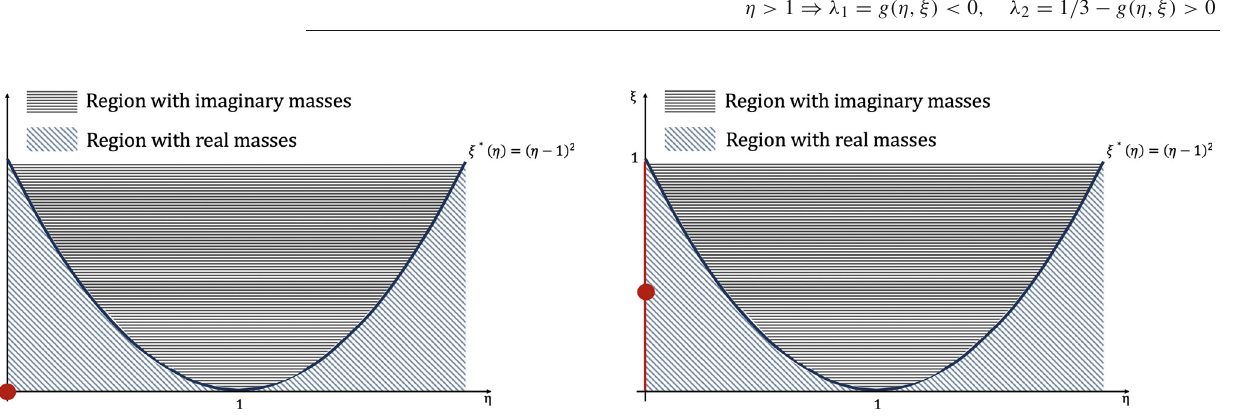
Fig. 2 In the space defined by parameters (η,ξ) some classes of mod- els (1) could be represented with a representative point in the η ξ − plan. On the abscissa axis ( ξ = 0) are representable STFOG models with a minimally coupled ( ξ = 0 ⇒ f R φ = 0), while on the ordinate axis ( η = 0) are represented STFOG models with either a massless scalar field ( η = 0 ⇒ m φ = 0) or models with a massive scalar field non- minimally coupled in General Relativity ( η = 0 ⇒ m R → ∞ ). In the origin of the axes, (η,ξ) ≡ ( 0 , 0 ) , are representable all f ( R ) -models